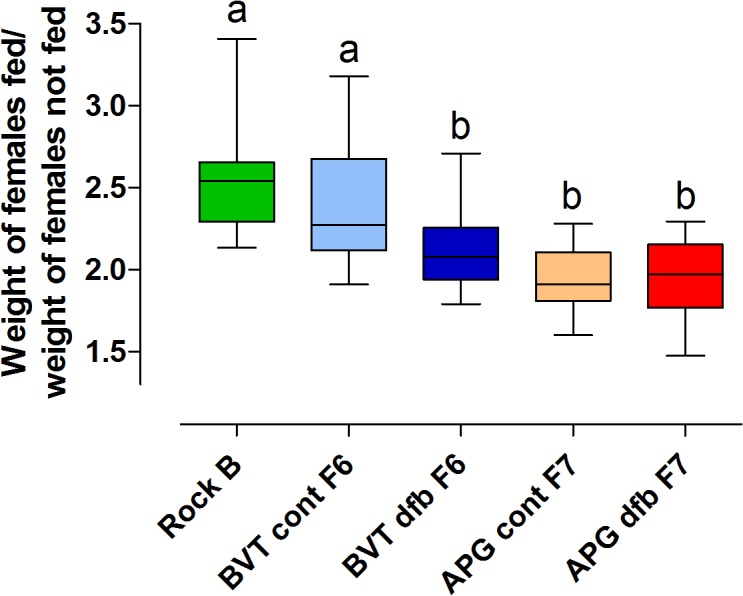
The amount of blood ingested by Rockefeller (Rock) females, and DFB-selected (dfb) or control (cont) mosquitoes from Boa Vista (BVT) and Aparecida de Goiânia (APG).Each box-plot displays the median, the interquartile range and the minimum and maximum amount of blood ingested by each group. Distinct letters indicate significant differences among groups (t test; P < 0.05).